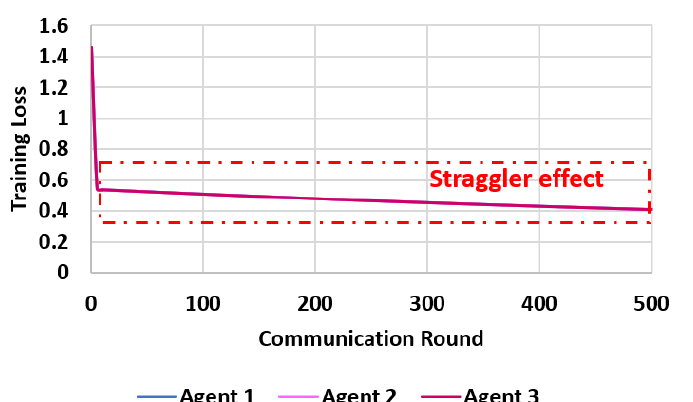
Figure 9. Straggler effects on participating FL agents’ (three agents and two stragglers) model loss for the prediction of agents’ resource-sharing capability.